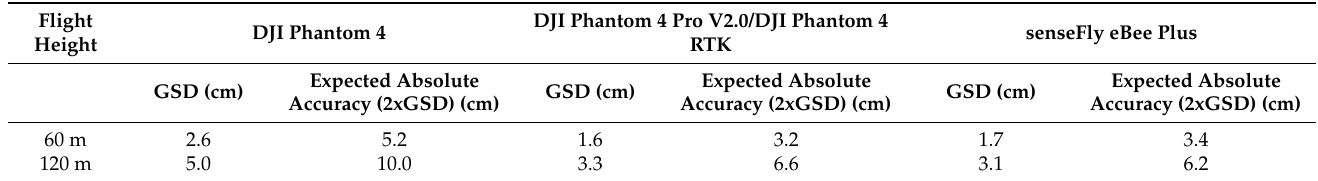
Table 3. Expected absolute accuracy based on flight height and achievable GSD at different flight